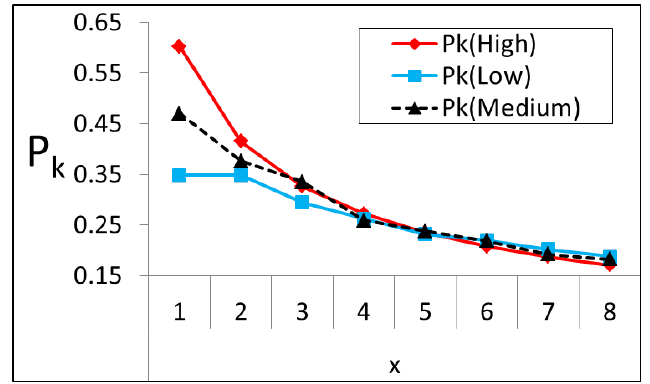
Figure 4. P k results for High, Medium and